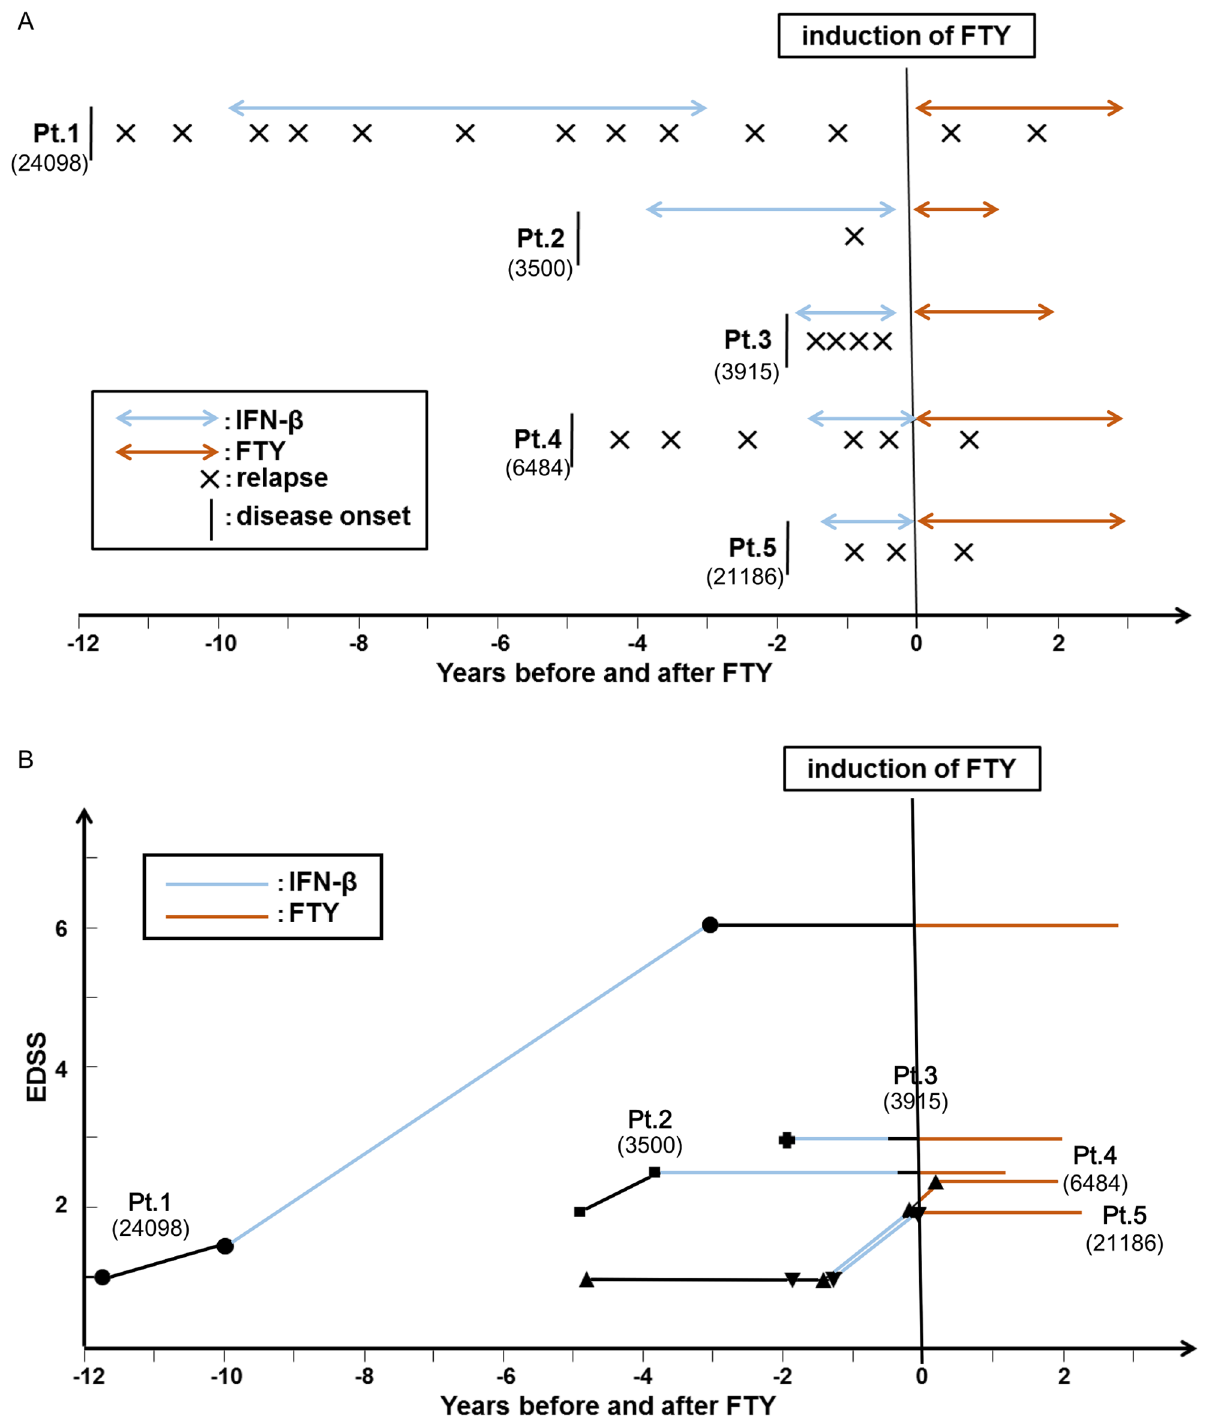
Fig 3. Fingolimod is effective in IFN- β non-responder patients with high Sema4A. Relapses (A) and EDSS (B) of all the patients with high Sema4A in Osaka University Hospital who changed from IFN- β to fingolimod treatment are shown. (The orange and blue lines represent duration of treatment with fingolimod and IFN- β , respectively.) During IFN- β treatment, the patients had many relapses and disease progressed. However, fingolimod tended to be effective in reducing the relapse rate (1.36 ± 0.80 (IFN- β ) to 0.27 ± 0.25 (FTY), p = 0.054; Mann-Whitney U test) and in preventing further increase in EDSS in all patients (0.45 ± 0.37 (annual EDSS change, IFN- β ) to 0.0 ± 0.0 (annual EDSS change, FTY), p = 0.046; Mann-Whitney U test). The Sema4A levels (U/ml) of each patient are as follows: Pt.1; 24098, Pt.2; 3500, Pt.3; 3915, Pt.4; 6484, Pt.5; 21186, indicated within the parenthesis.